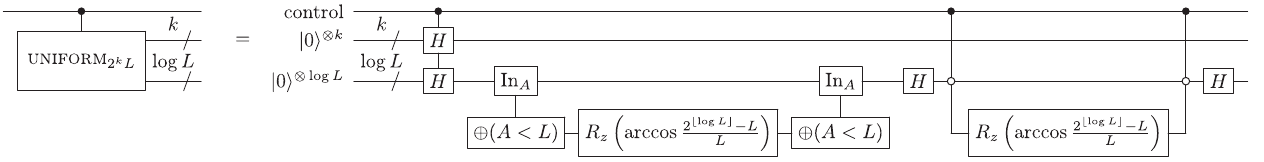
FIG. 12. A circuit that uses amplitude amplification [70,71] to conditionally and reversibly prepare the uniform superposition ffiffiffiffiffiffiffiffi P p 2 k L − 1 l i , where L is odd, starting from the j 0 i state. The circuit spans k þ 2 log L þ O ð 1 Þ qubits and has a T count of 2 k L Þ ð 1 = l ¼ 0 j 2 k þ 10 log L þ O ( log ð 1 = ϵ Þ ) . If the control is omitted, the T count drops to 8 log L þ O ( log ð 1 = ϵ Þ ) . If L ¼ 1 , the R needed and the T count drops to 2 k . If L ¼ 1 and the control is omitted, the T count is zero.